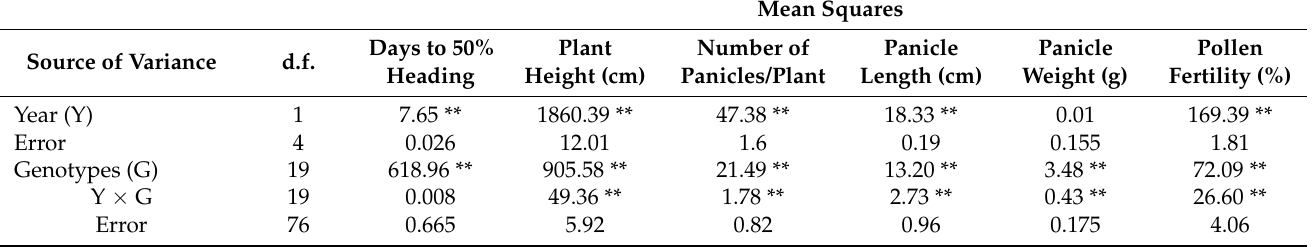
Table 6. The combined analysis of yield and its components of twenty rice genotypes over the two years.